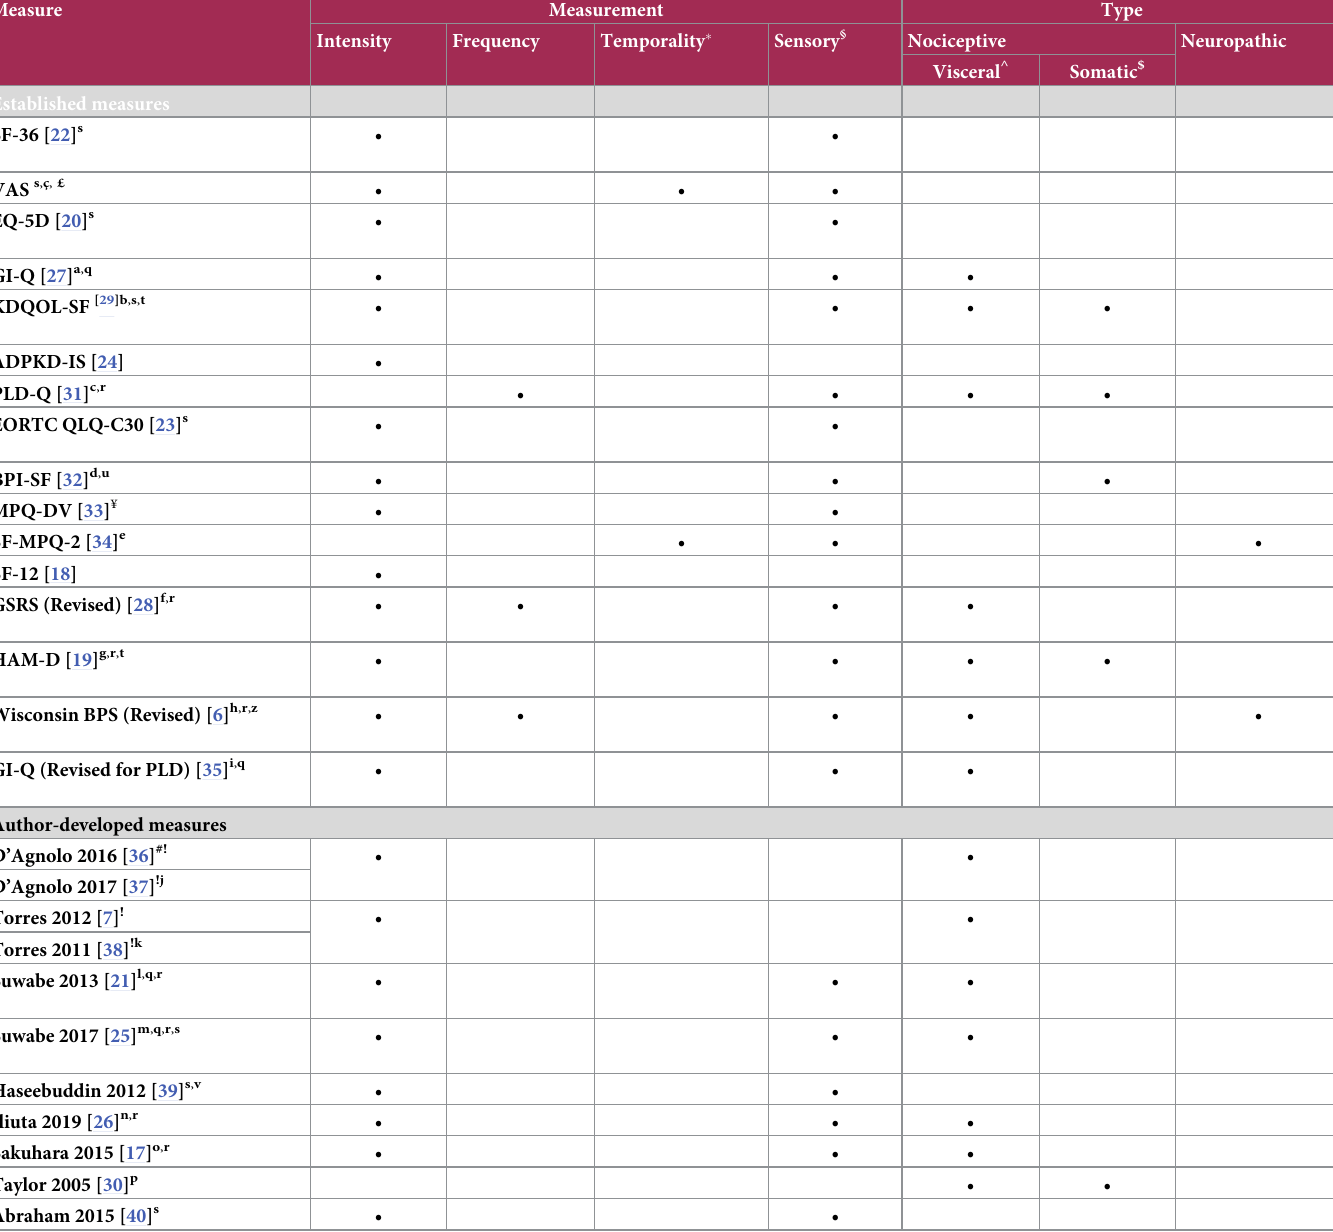
Table 3. Dimensions of pain assessed by measures: Measurement and type of